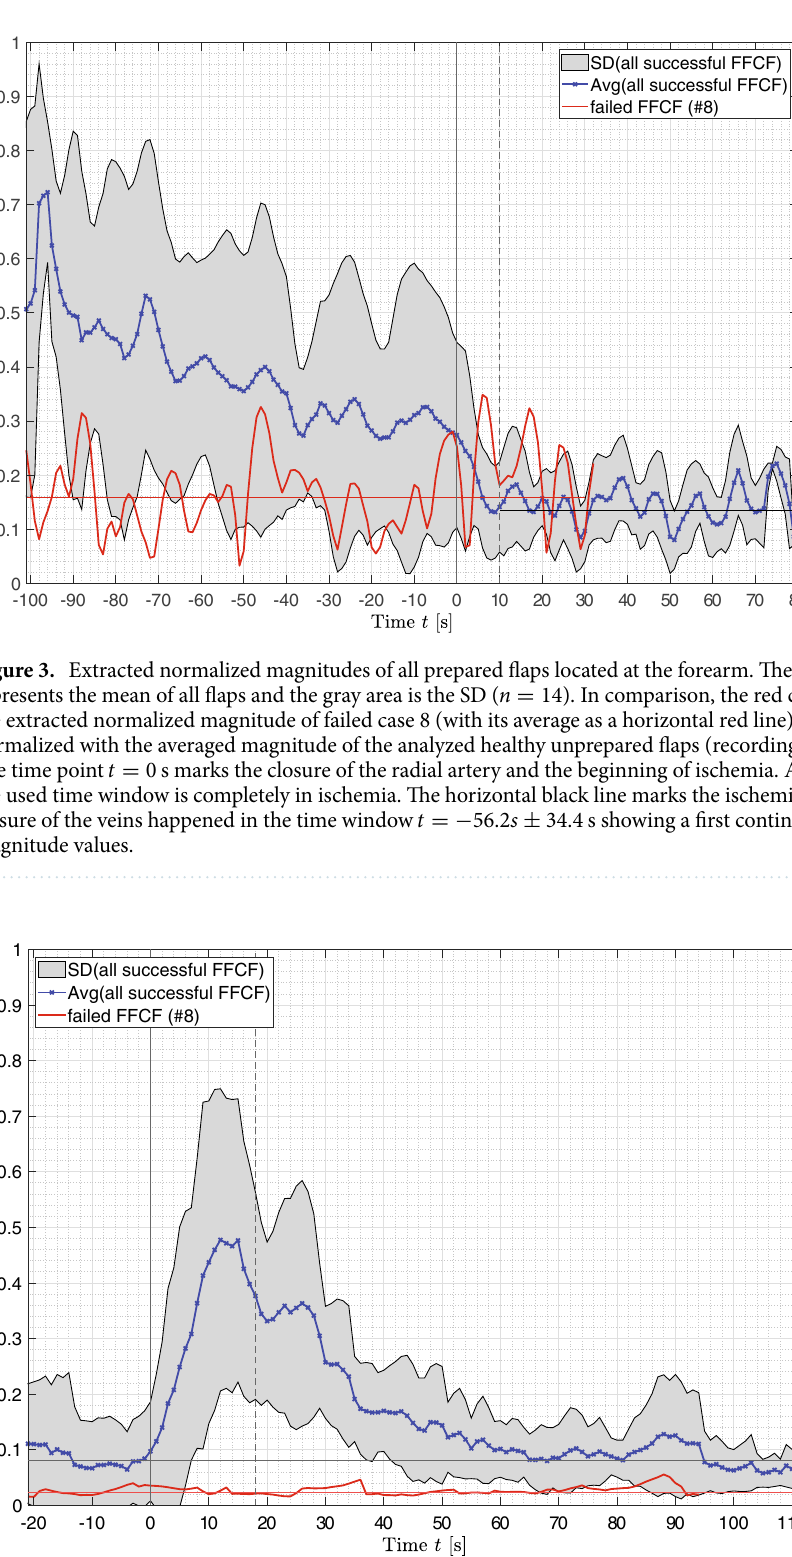
Figure 4. Perfusion index PI. The blue curve represents the average of all successfully transplanted FFCFs and the gray area includes the SD. In comparison, the red curve shows the PI of failed flap #8. The PI data are normalized with the highest extracted PI value in all data PI max = 1.072 . The time point t = 0 s marks the documented reperfusion. The reperfusion is detectable in the data after t = 18.08 s (first detection of a pulse rate in the rPPG signal of the FFCF after reperfusion). The horizontal black line marks the baseline of PI of all successful reperfused flaps, while the horizontal red line marks the average of PI of the failed